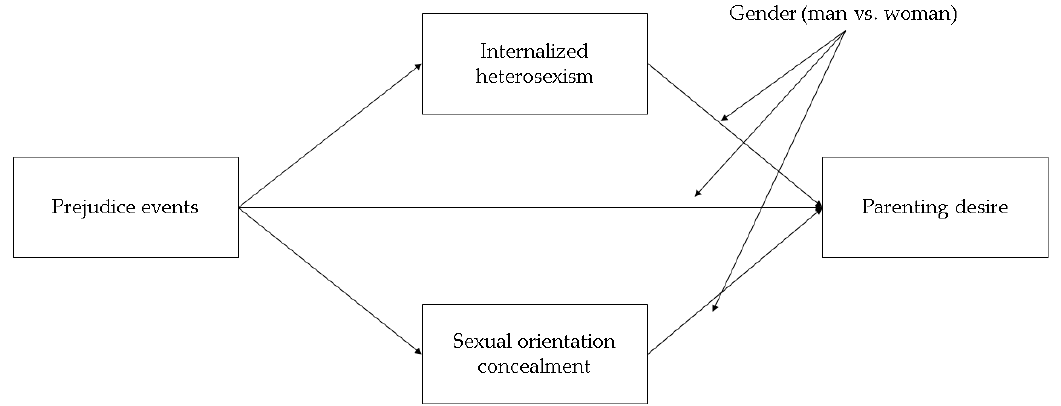
Figure 1. The hypothesized moderated mediation model. For reasons of simplification, control variables were not reported in the figure. variables were not reported in the